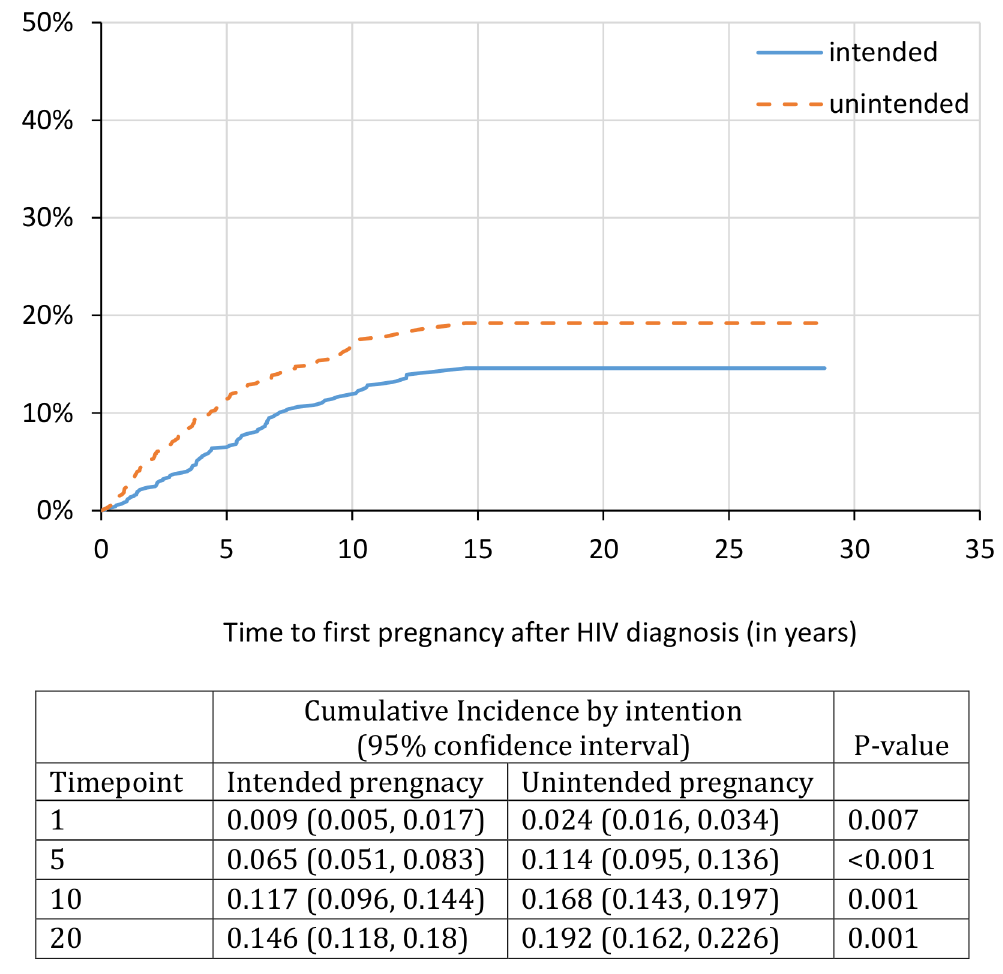
Fig 2. Time to first pregnancy after HIV diagnosis by intention status. This figure demonstrates the estimated time to first pregnancy event (inclusiveof live births, terminations and miscarriages/stillbirths) for all women living with HIV in our sample that providedHIV diagnosisdate and estimated date of pregnancy (n = 1,136). These pregnancies are stratified by self-reportedintention as either intendedor unintendedpregnancy. This figure demonstrates the cumulativeincidenceestimates and 95% confidenceintervalsat 1-, 5-, 10-, and 20-yearsfor unintended and intendedpregnancies. (20.0% vs. 11.8%), born in Canada (63.9% vs. 39.1%), be currently single (60.0% vs. 45.5%), co- infected with HCV (38.7% vs. 21.8%), have a history of incarceration (45.8% vs. 26.4%), have a history of injection drug use (38.7% vs. 23.6%), initiated ART before the year 2000 (29.0% vs. 15.5%), and to report having been previously diagnosed with a mental health disorder (inclu- sive of depression, anxiety, post-traumatic stress disorder and addiction) (49.0% vs. 32.7%). With respect to pregnancy experiences, women with an unintended vs. intended recent/ current pregnancy were more likely to report feeling unhappy about the referent pregnancy (56.1% vs. 7.3%) and identifying the pregnancy experience as ‘one of the worst times of [her] life’ (60.0% vs. 16.4%). Women who reported a recent/current pregnancy as unintended vs. intended were also more likely to report pregnancy termination (28.4% vs. 1.8%).